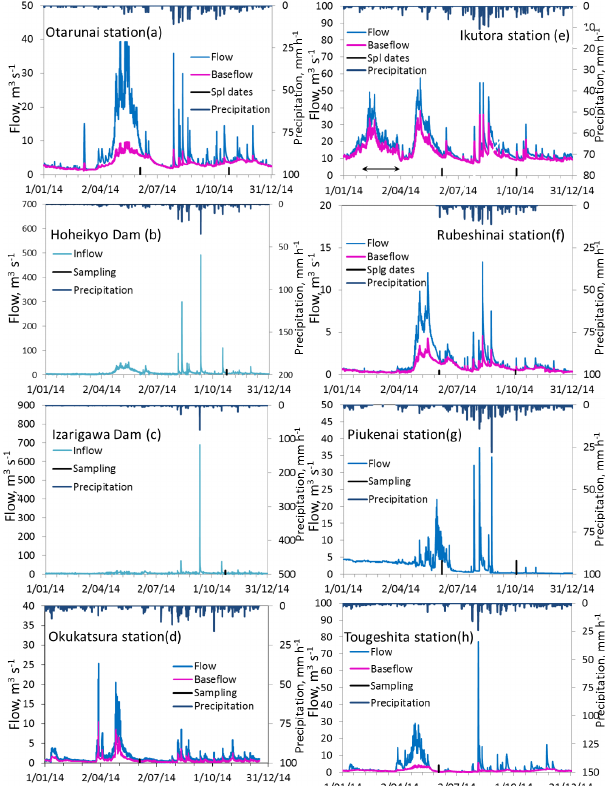
Figure 4. Hourly flows at Otarunai station (a) , Hoheikyo (b) and Izarigawa (c) dams, Okukatsura station (d) , Ikutora station (e) , Rubeshinai station (f) , Piukenai station (g) , and Tougeshita sta- tion (h) . The sampling times of June, July, and October are demon- strated by vertical